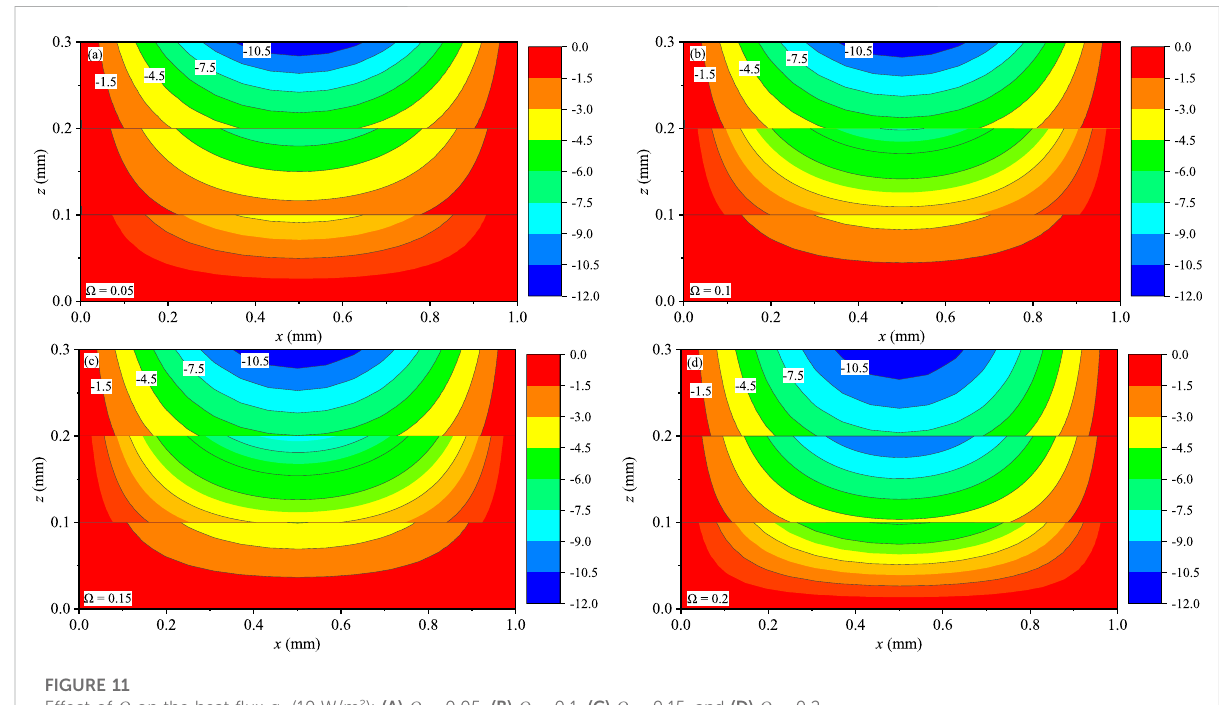
FIGURE 11 Effect of Ω on the heat fl ux q y (10 W/m 2 ): (A) Ω = 0.05, (B) Ω = 0.1, (C) Ω = 0.15, and (D) Ω =